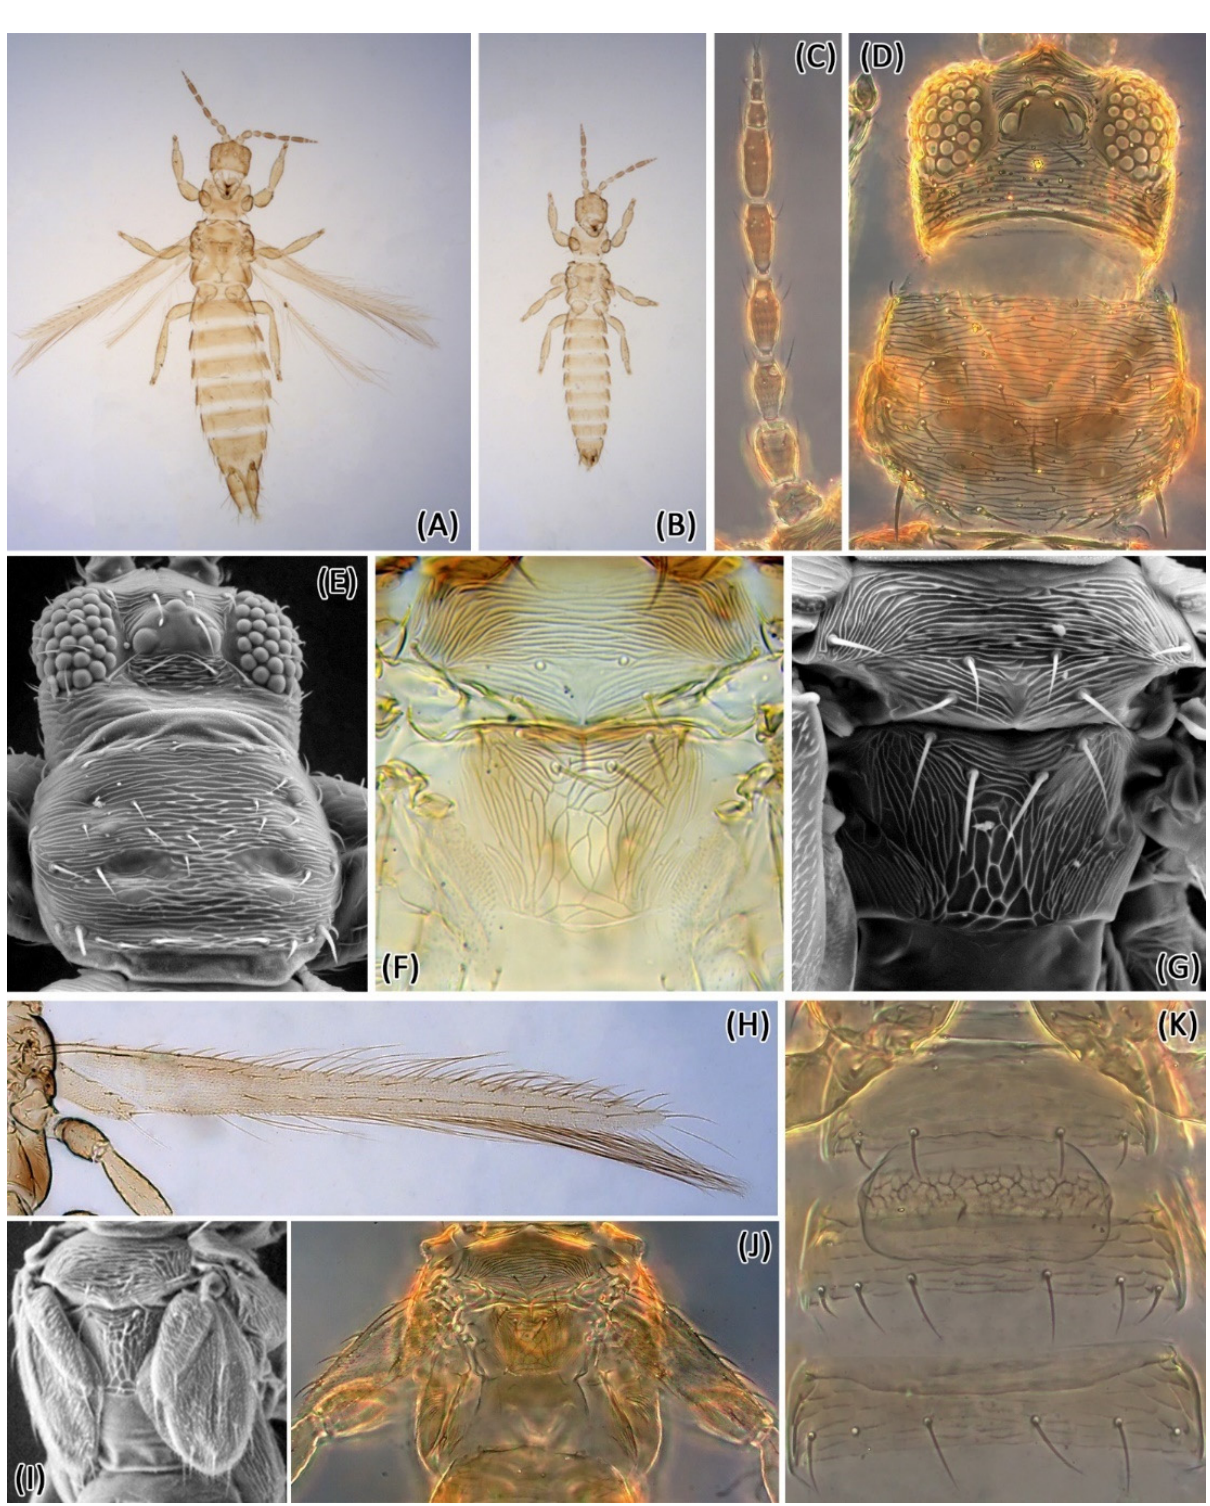
Figure 2. Enneothrips enigmaticus sp. n. ( A ) Female; ( B ) Male; ( C ) Antenna; ( D ) Head and pronotum; ( E ) Head and pronotum (SEM); ( F ) Meso- and metanotum; ( G ) Meso- and metanotum (SEM); ( H ) Fore wing (female); ( I ) Wings (male) (SEM); ( J ) Wings (male); ( K ) Abdominal sternites II–IV (male).